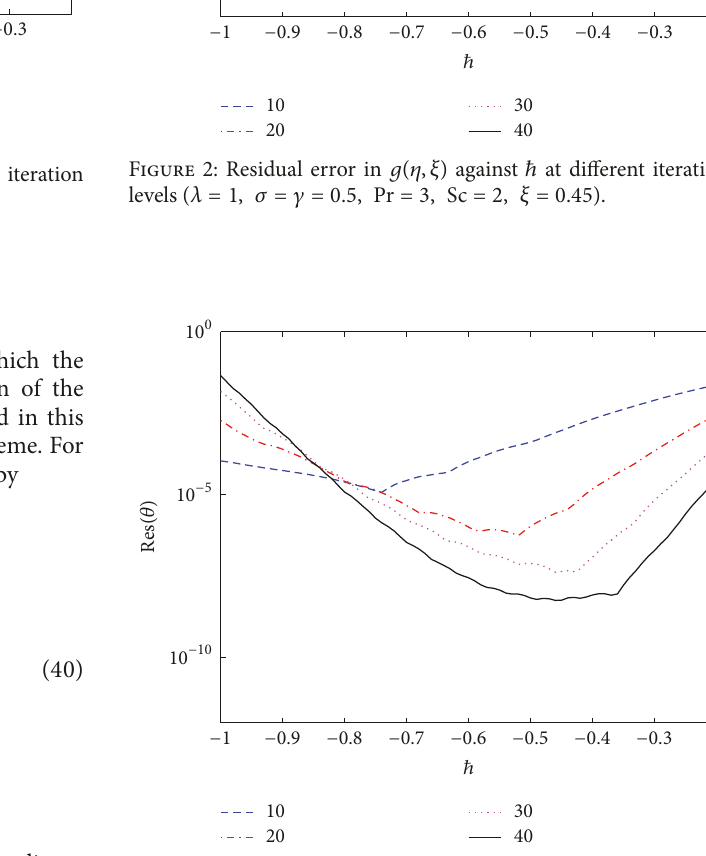
Figure 3: Residual error in 𝜃(𝜂, 𝜉) against ℏ at different iteration levels ( 𝜆 = 1, 𝜎 = 𝛾 = 0.5, Pr = 3, Sc = 2, 𝜉 = 0.45